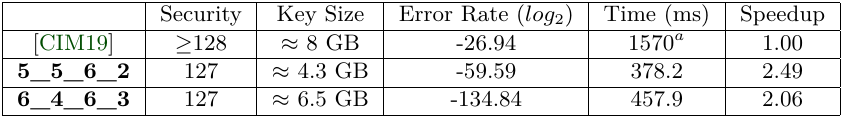
Table 4: Comparison between implementations of a 6-bit-to-6-bit